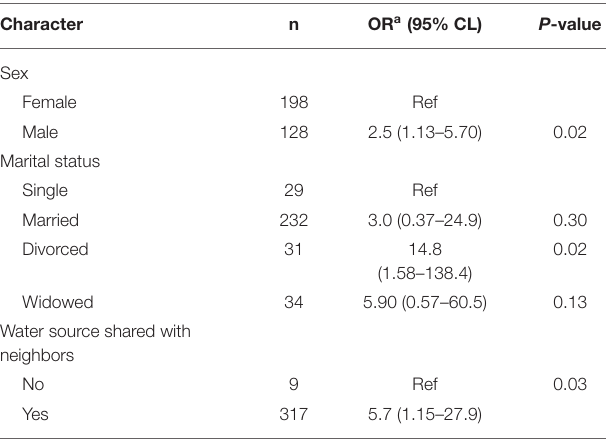
TABLE 5 | Factors associated with Cryptosporidium infection in the adult HIV population in Namwala District ( n = 326).